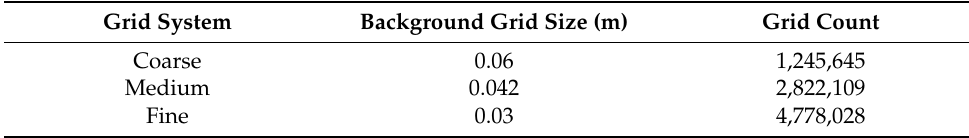
Table 2. Grid number for uncertainty